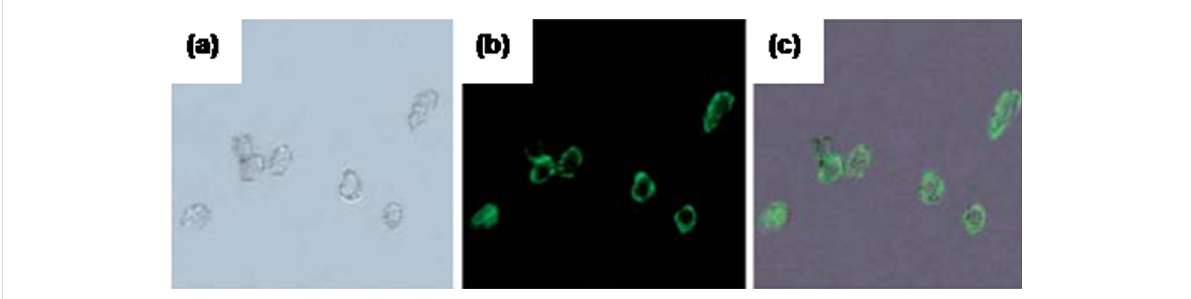
Figure 4: Images of live HeLa cells after being incubated with Fe 3 O 4 /NaYF 4 nanocomposites biolabeled with transferrin. (a) Bright field, (b) fluores- cent images in dark field and (c) superposition of (a) and (b). Reproduced with permission from [31]. Copyright 2010 Royal Society of Chemistry.